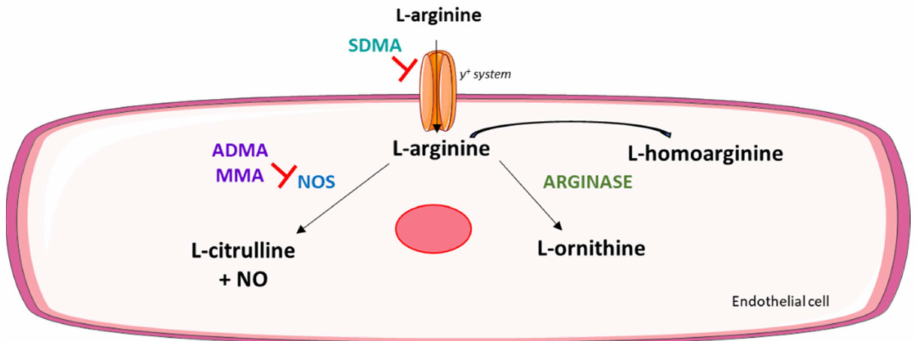
Figure 1. A schematic representation of the L -arginine/nitric oxide metabolic pathway in an endothe- lial